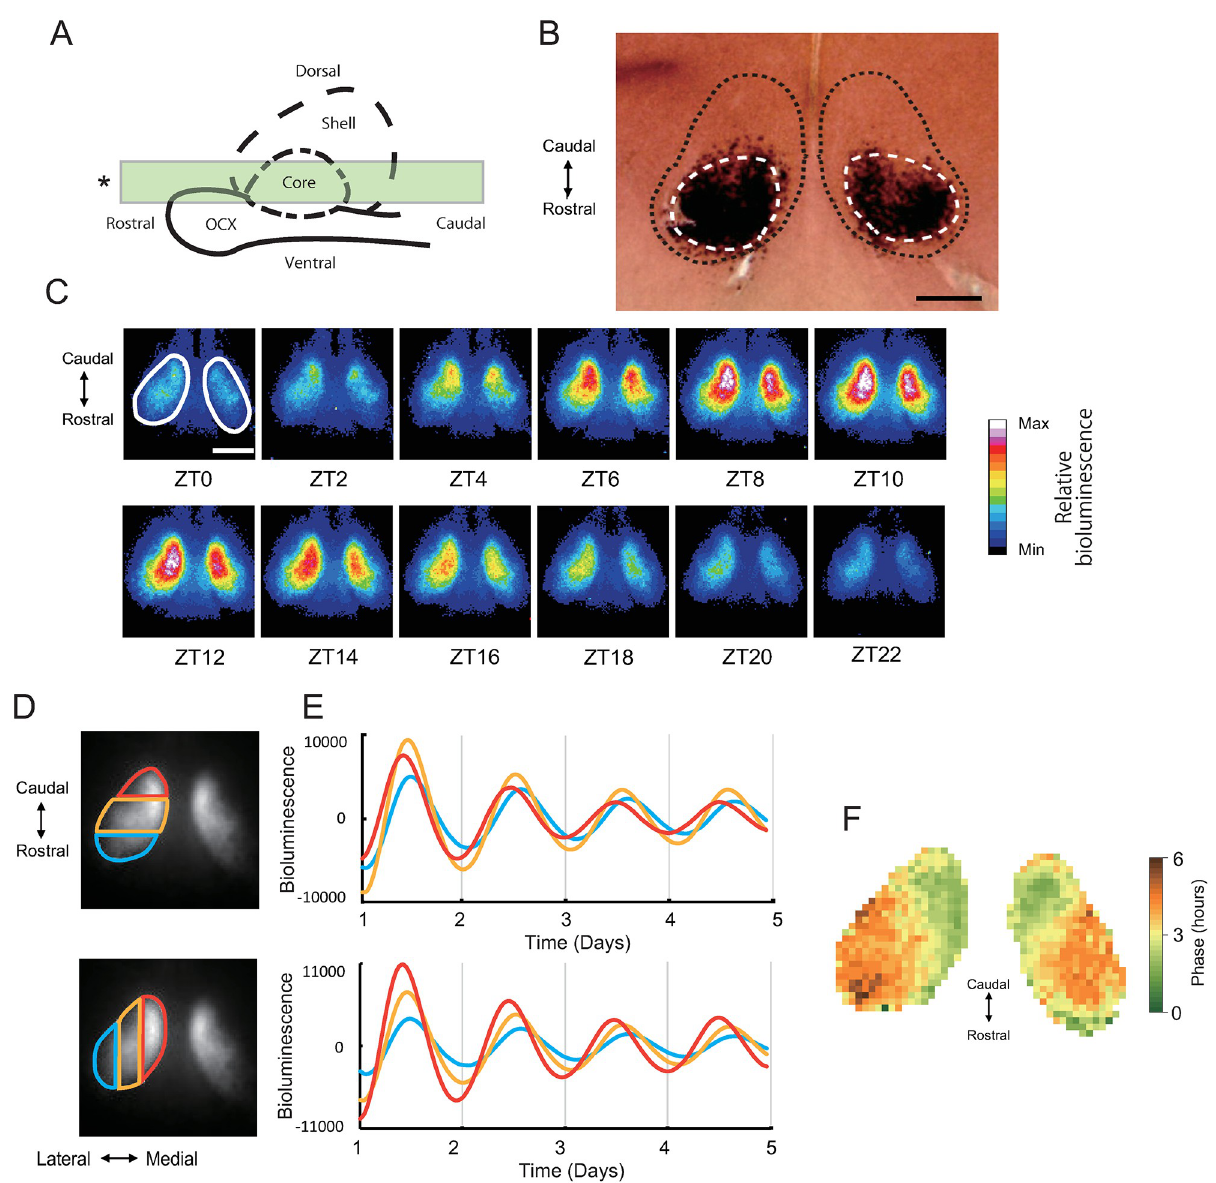
Fig 1. Schema of the SCN slices and Per2 ::dLu c bioluminescence rhythm in the SCN. (A) A schematic diagram of the sagittal section of the SCN (modified from Nagano et al., 2019). The outline of the SCN is denoted by a dashed line (considered as the shell region of the SCN), and the outline of the VIP region (considered as the core region of the SCN) by a dashed line. The green rectangle ( � ) in the picture indicates the location of the horizontal slice excision for the present study. (B) Representative horizontal section of the SCN showing the r Vip -expressing neurons by in situ hybridization. The outline of the core region was identified by r Vip -expressing neurons. Black dashed line: outline of the SCN, White dashed line: core region of the SCN, Scale bar: 250 μ m. (C) Representative bioluminescence images of a horizontal slice of the rat SCN. White line indicates the outline of the SCN. The beginning of the first light period in the former light-dark cycle before decapitation was described as (projected) ZT0. Scale bar: 500 μ m. Data shown in C-F are from a single slice. (D) three ROIs were set on a unilateral SCN with the same rostro-caudal width and same medial-lateral width. (E) The average of the bioluminescence intensity of each ROI was plotted against time. The phase in the caudal ROI (red) are advanced compared to those of the middle (yellow) and rostral (blue) fragments (upper panel). The phases in the medial ROIs (red) are advanced compared to those of the middle (yellow) and lateral (blue) fragments (lower panel). (F) Phase map of 1 st acrophase (after the first pZT0) of the SCN. This figure indicates that the phase wave propagates from the green region to the brown region. The phase was advanced in caudal and medial relative to the rostral and lateral, indicating that the phase wave propagates from the caudal side to the rostral side, and from the medial side to the lateral side. Grid size: 32 μ m.